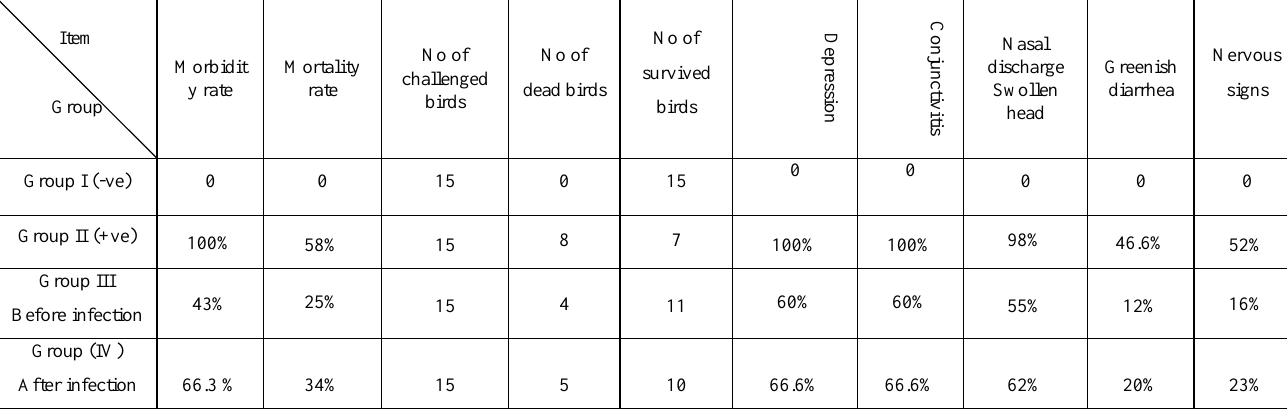
Table 4: The protective effect of ECV extract on the clinical finding of chickens after VNDV genotype VII